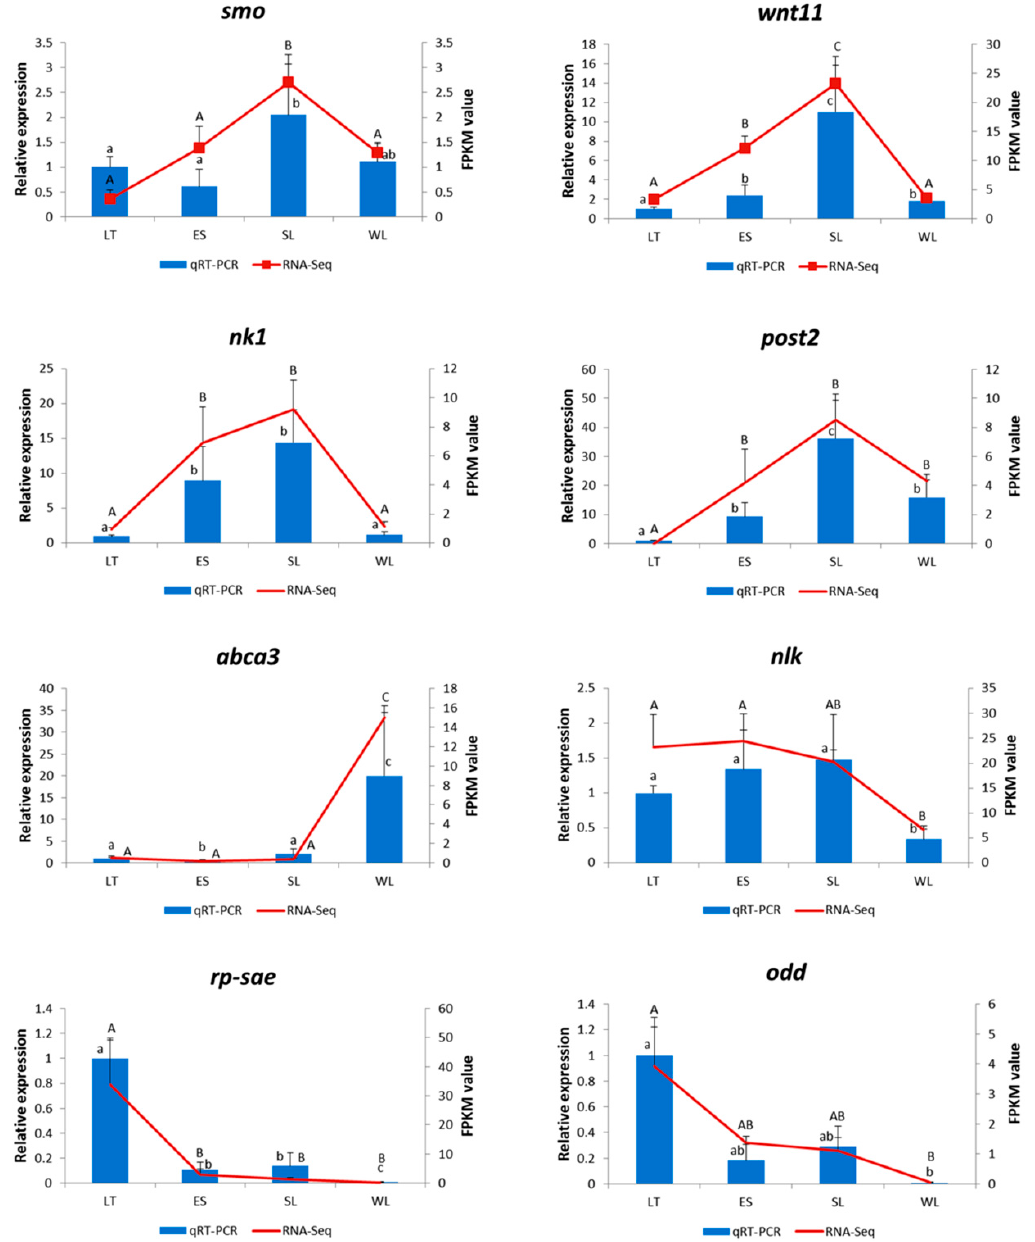
Figure 5. Validation of the RNA-Seq data using qRT-PCR. The blue columns represent the qRT-PCR results; the red lines show the FPKM value. Different characters indicate the significant difference ( p < 0.05), with the uppercase letter for qRT-PCR and the lowercase for RNA-Seq. smo belongs to profile11, wnt11 and post2 belong to profile18, nk1 belongs to profile16, abca3 belongs to profile10, nlk and odd belong to profile9 and rp-sae belongs to profile2, respectively.